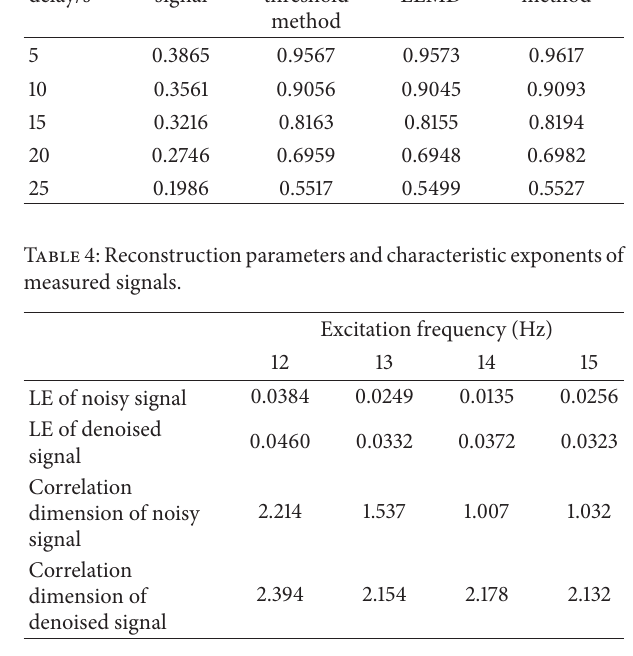
respectively. The chaotic attractor is obtained in Figure 13(e), and the maximal Lyapunov exponent (LE) is 0.313. The meas- ured signal is polluted by ambient noise apparently.